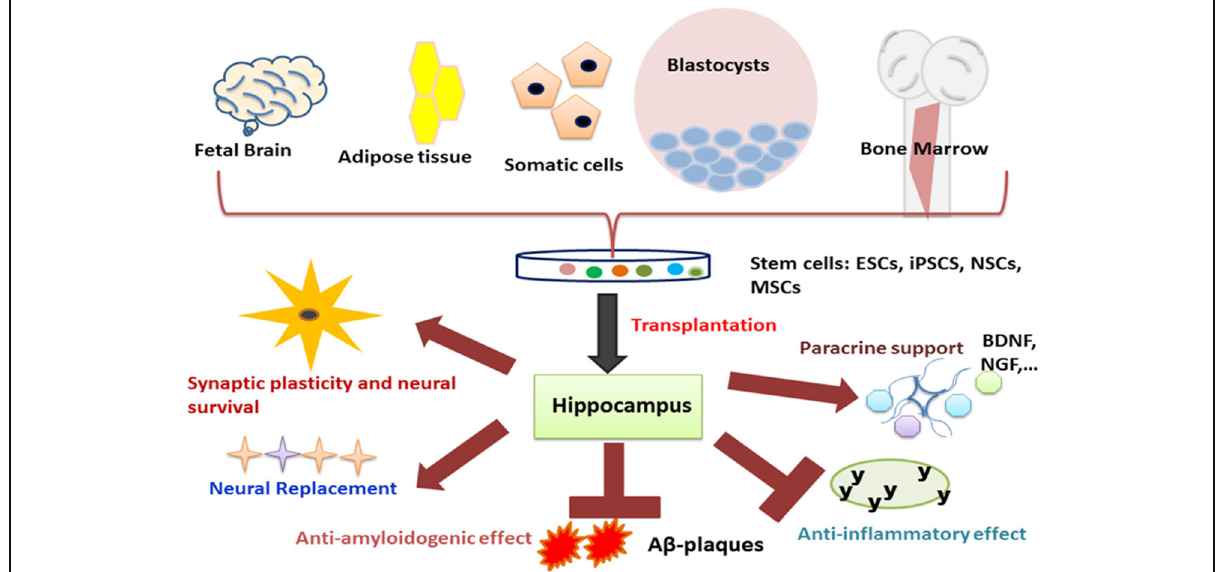
Fig. 5 The potential mechanistic actions exerted by stem cells against Alzheimer ’ s